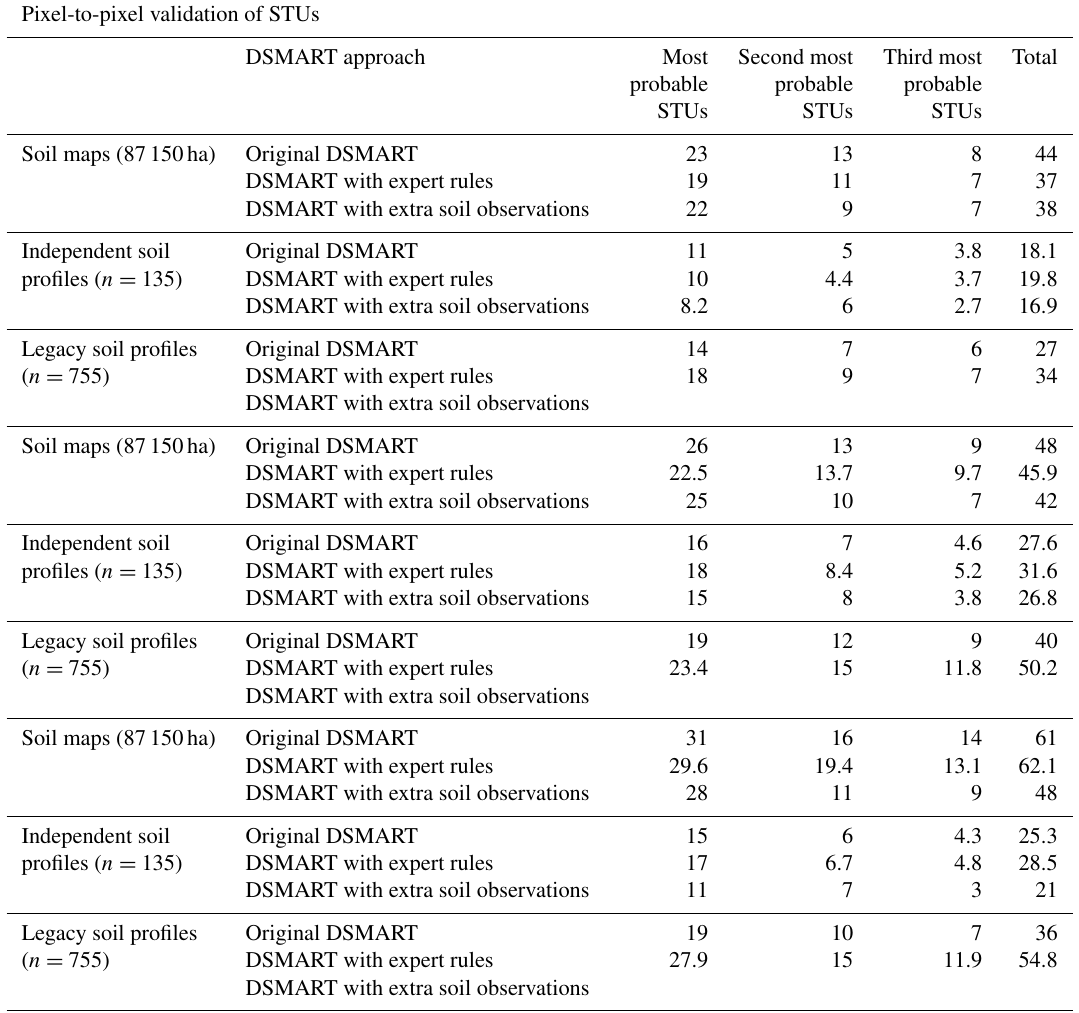
Figure 7. Violin plots of the relative importance of each environmental covariate used in the (a) original DSMART approach, (b) DSMART with expert rules and (c) DSMART with extra soil observations. Table 3. Overall accuracies (%) obtained using various external validation approaches for the three most probable STUs. Pixel-to-pixel validation of